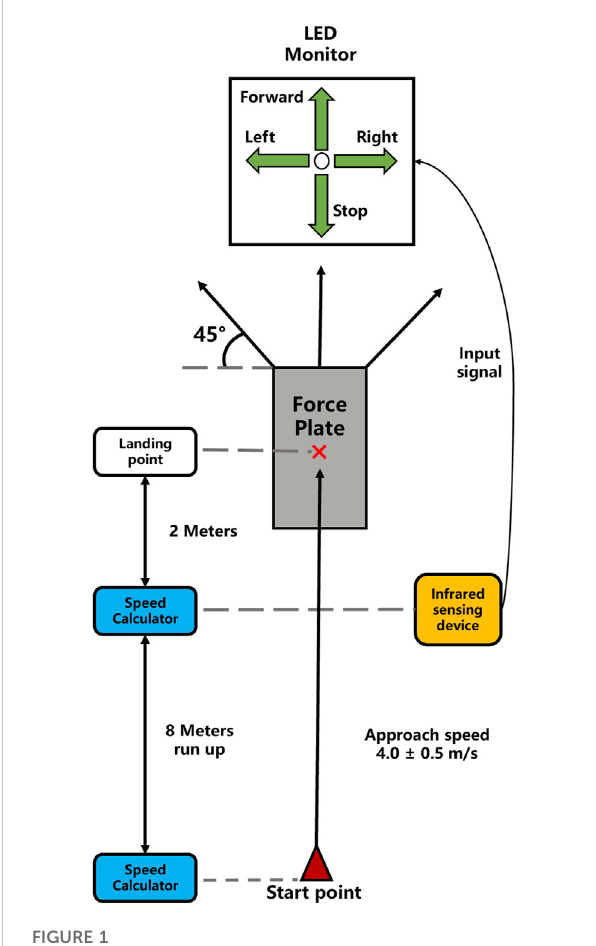
FIGURE 1 Layout of experimental